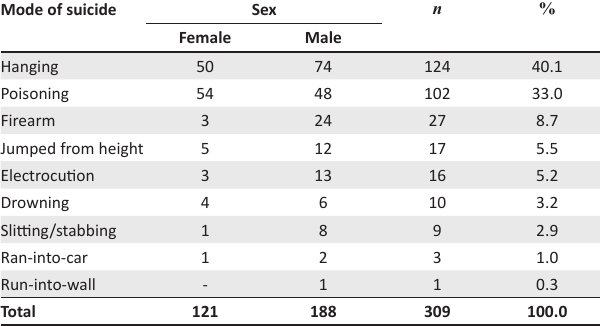
TABLE 2: Mode of suicide by